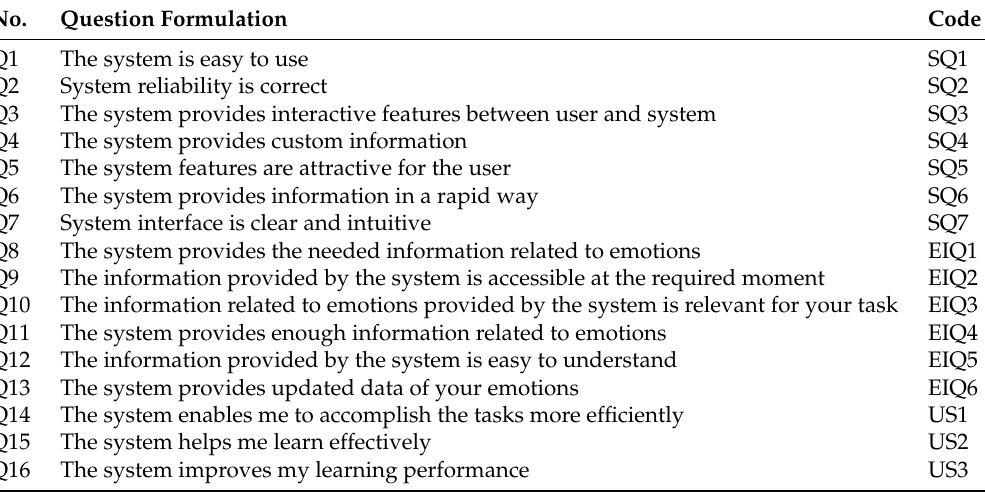
Table 1. Questionnaire for the